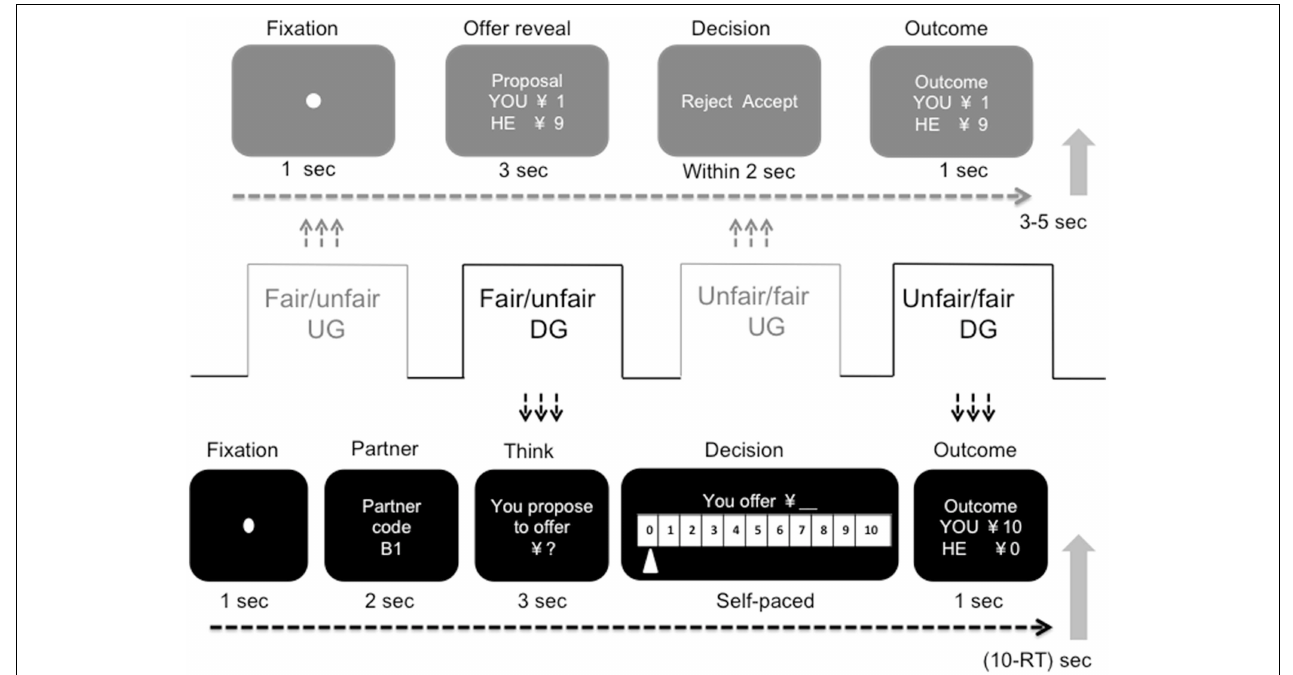
FIGURE 1 | Schematic display of the experimental paradigm and design of a single trial in the ultimatum game and the dictator game. The experimental session consisted of four blocks, two for the ultimatum game, with 36 trials in each block, and two for the dictator game, with 30 trials in each. For the ultimatum game block, the participants played the role of responder and were asked to make a decision on previously collected proposals. For the dictator game block,